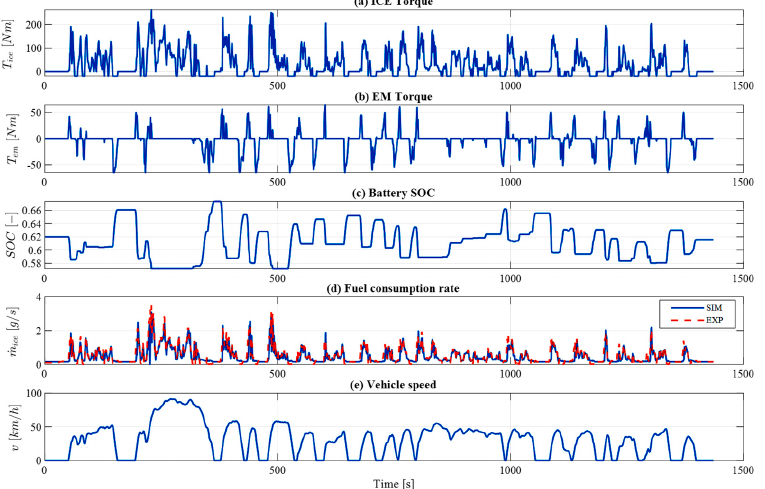
Figure 17. Simulation results with no limitation on the temperature on UDDS driving cycle: ( a ) ICE torque, ( b ) EM torque, ( c ) Battery SOC, ( d ) Fuel consumption rate and ( e ) Vehicle speed.